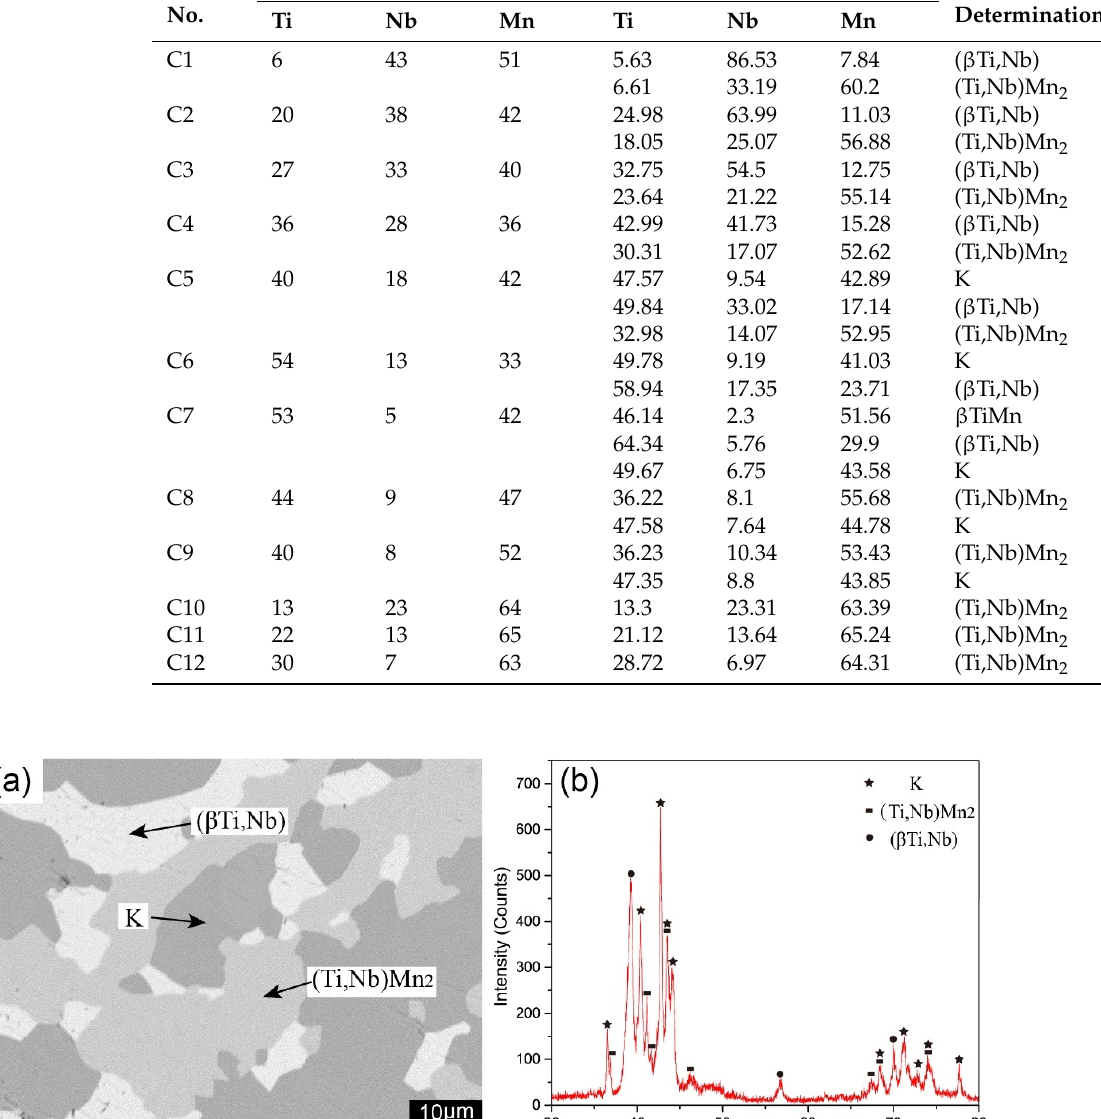
Figure 25. Alloy C7 annealed at 1373K for 40 days: ( a ) BSE images, ( b ) XRD patterns. Figure 26a shows the microstructure of the equilibrium alloy C3 annealed at 1100 °C for 40 days, which contains ( β Ti,Nb) (white base phase) and (Ti,Nb)Mn 2 (gray phase) based on the EPMA result. Figure 27a shows the two-phase K + ( β Ti,Nb) microstructure for the equilibrium alloy C6 that agrees with the XRD result presented in Figure 27b.